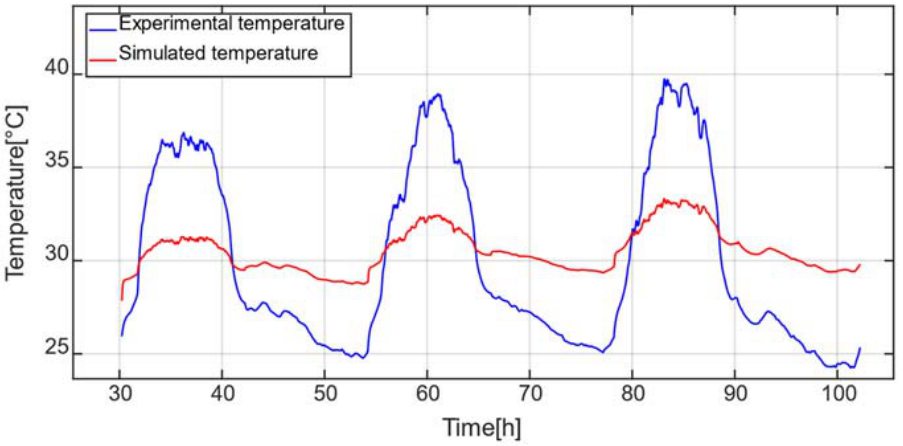
Figure 8. Experimental temperature and simulated temperature with coating solution on the external surface as a function of time.